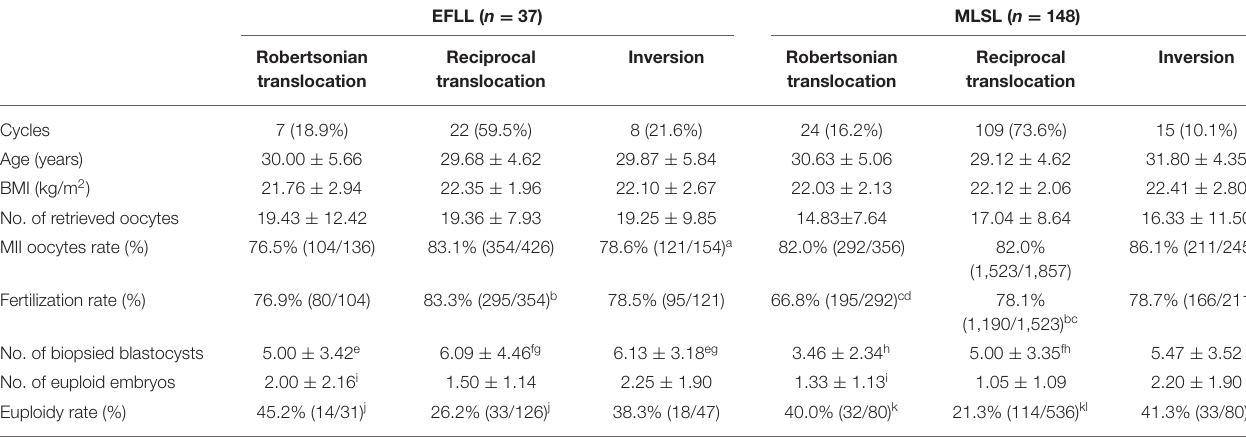
BMI, body mass index. Data are presented as mean ± SD or % (no./total no.). a − l p < 0.05, for analysis of variance comparison/Fisher exact test/ χ 2 -test between columns in the same row.